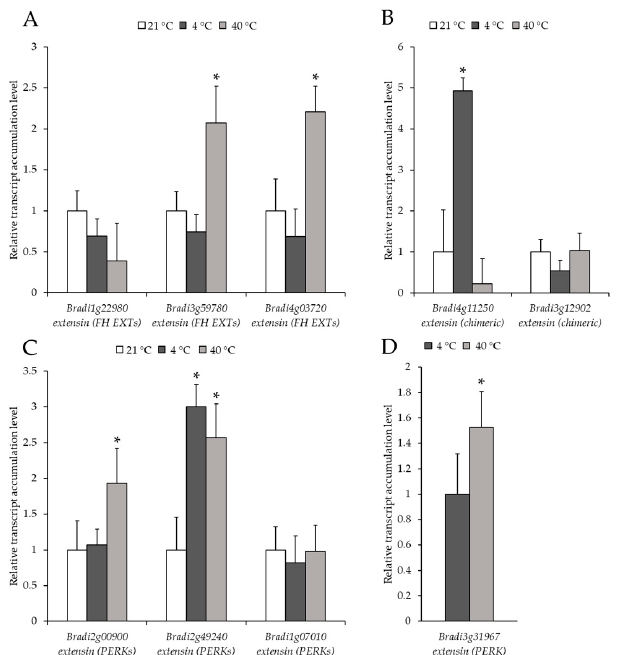
Figure 8. Relative level of transcript accumulation of the extensins (EXT) genes: ( A ) formin ‐ homolog (FH) EXT: Bradi1g22980 , Bradi3g59780 , Bradi4g03720 , ( B ) chimeric EXT: Bradi4g11250 , Bradi3g12902 , ( C ) proline ‐ rich extensin ‐ like receptor kinase (PERK): Bradi2g00900 , Bradi2g49240 , Bradi1g07010 and ( D ) Bradi3g31967 . The relative expression levels were normalised to an internal control ( Bradi1g32860 , gene encoding ubiquitin) and calibrated to the control. Asterisks indicate significant differences from the control using the Student’s t ‐ test ( p < 0.05; mean ± SD, n = 3).